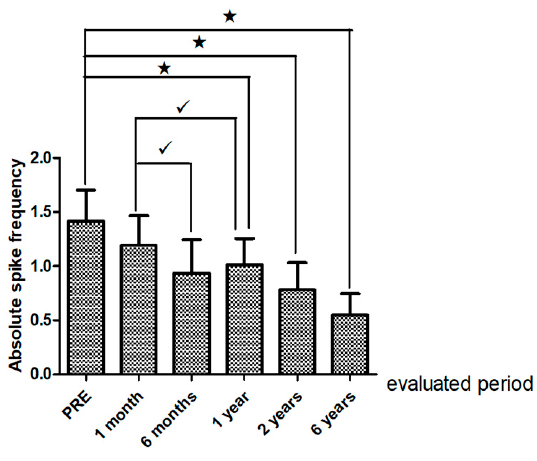
Figure 2. Absolute spike frequency (ASP) on pre-and postoperative Electroencephalogram EEG (one, six months and one, two and six year). Comparisons of pre-EEG with one, two and six years after epilepsy surgery ( ★ p < 0.05). Comparisons between one month postsurgical EEG and six months and one year post surgery ( √ p < 0.05) Friedman ANOVA and Sigh test. There were no differences in the SAF between the first year after and the other evaluated periods. Notice x axis: evaluated EFG period, y axis: mean and SEM of the ASF (spike/min).